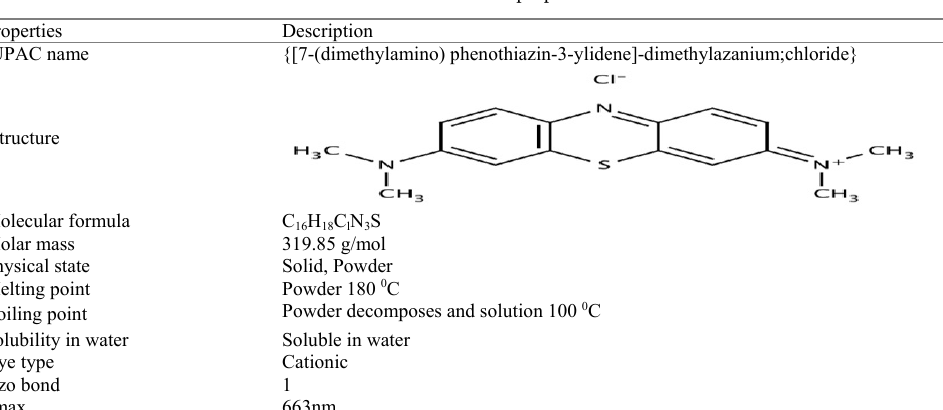
Table 1 Chemical structure and properties of MB Table 1. Chemical structure and properties of